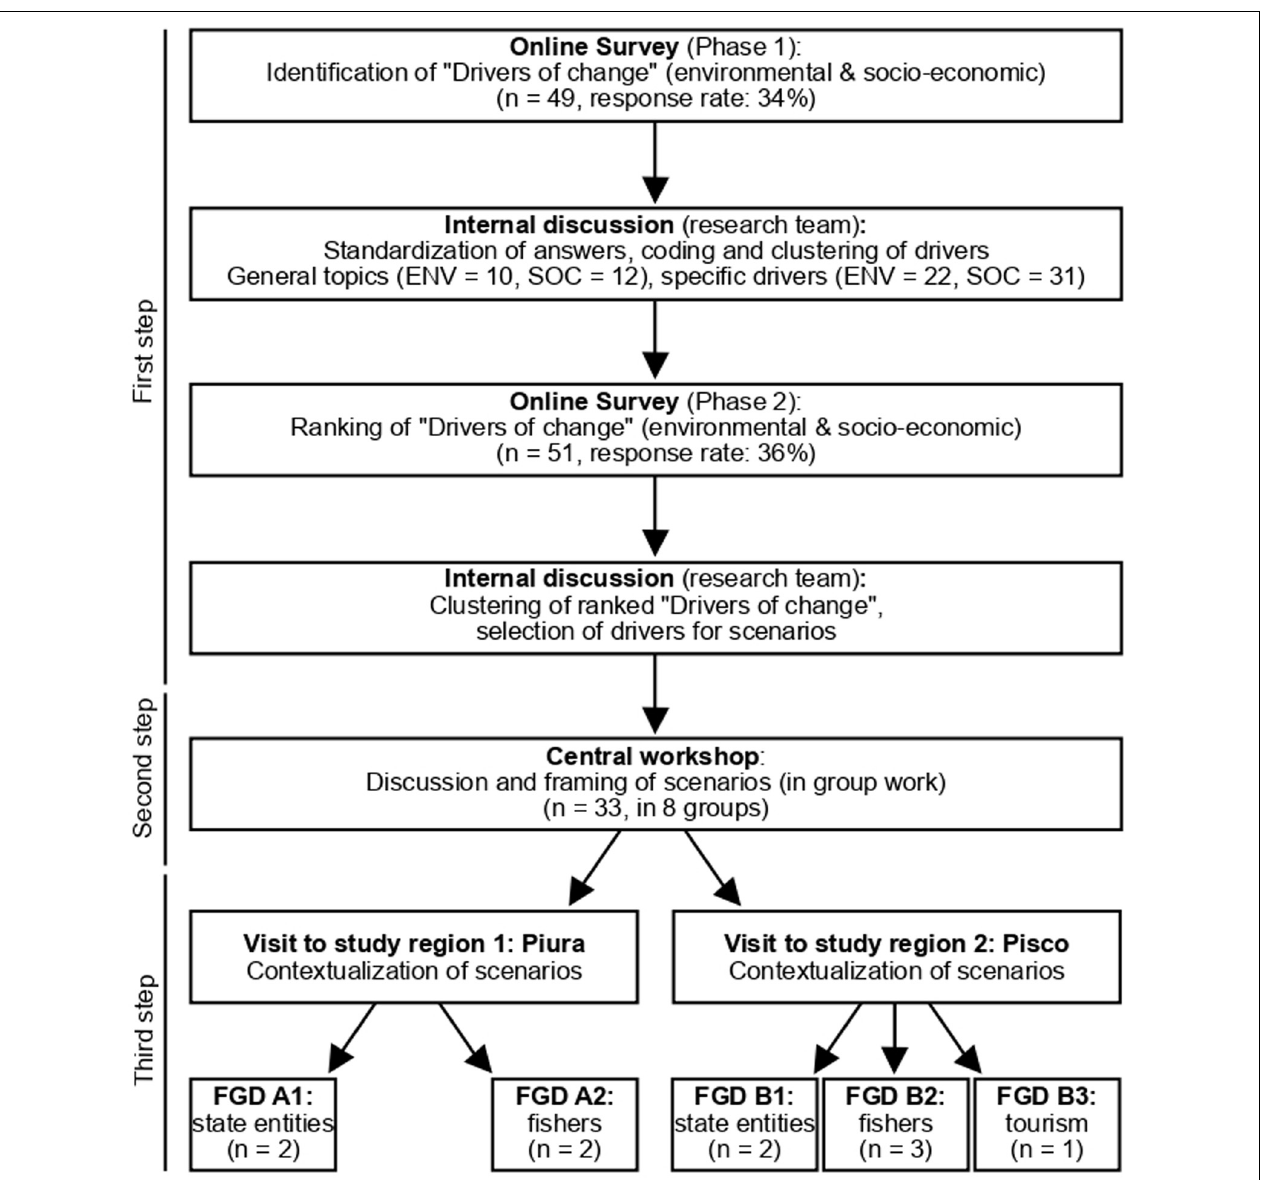
FIGURE 2 | Scheme of the designed participatory method, being divided in three steps. For each step, the sample size and a brief description of the main aim is provided. From top to the bottom: (1) the first step consisted of a two-phase online survey and in between coding of answers (sections “Identifying Drivers of Change: Reaching Out Through Online Surveys” and “Online Survey” of this manuscript); (2) the second step comprised of a central workshop (sections “Developing the Scenarios: A Participatory Stakeholder Workshop” and “Central Workshop”); and (3) the third step included several Focus Group Discussions (FGD) in two coastal regions of Peru (Piura in the north and Pisco in the south; section “Contextualizing the Scenarios: Enriching Scenarios Narratives With Visions of Local Stakeholders in Focus Group Discussions” and “Focus Group